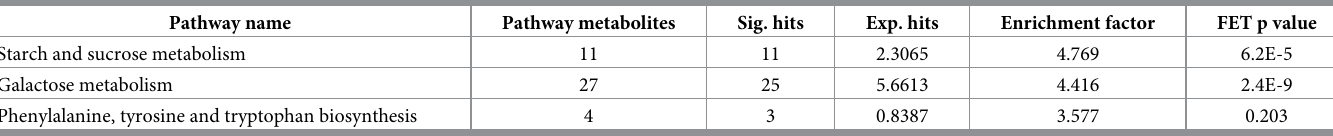
Table 2. Top significantly changed pathways based on their calculated enrichment factor and significance value. Pathway